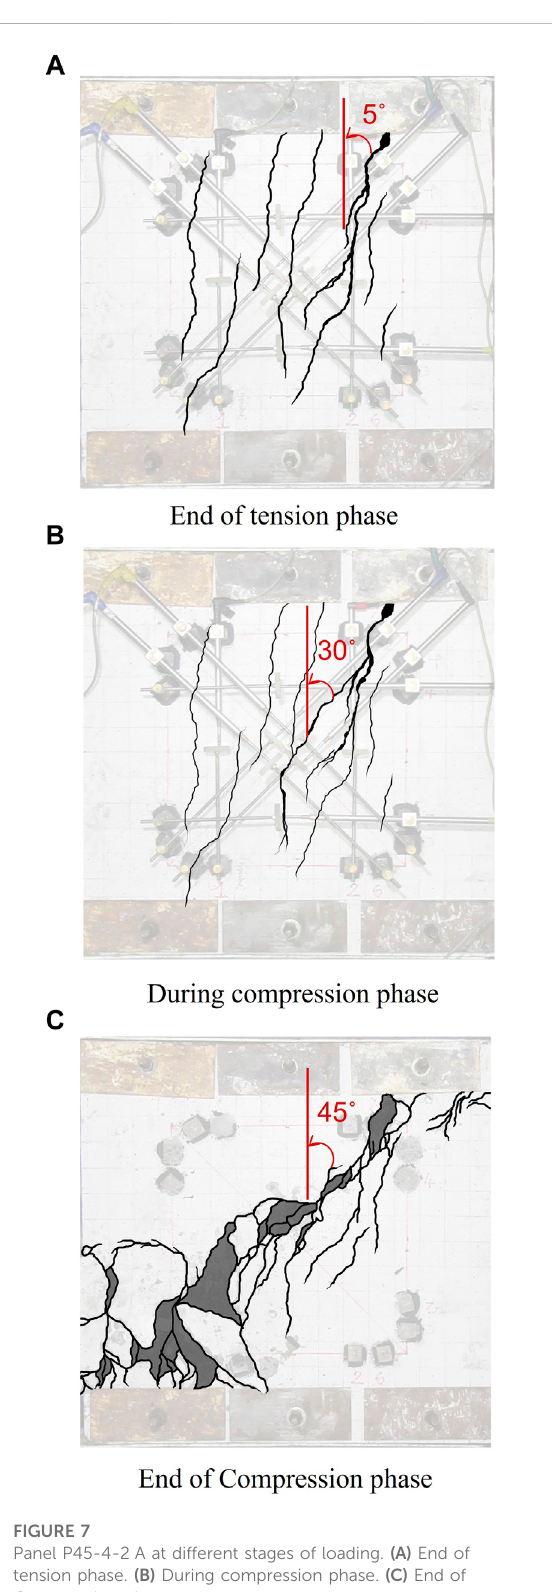
FIGURE 7 Panel P45-4-2 A at different stages of loading. (A) End of tension phase. (B) During compression phase. (C) End of Compression